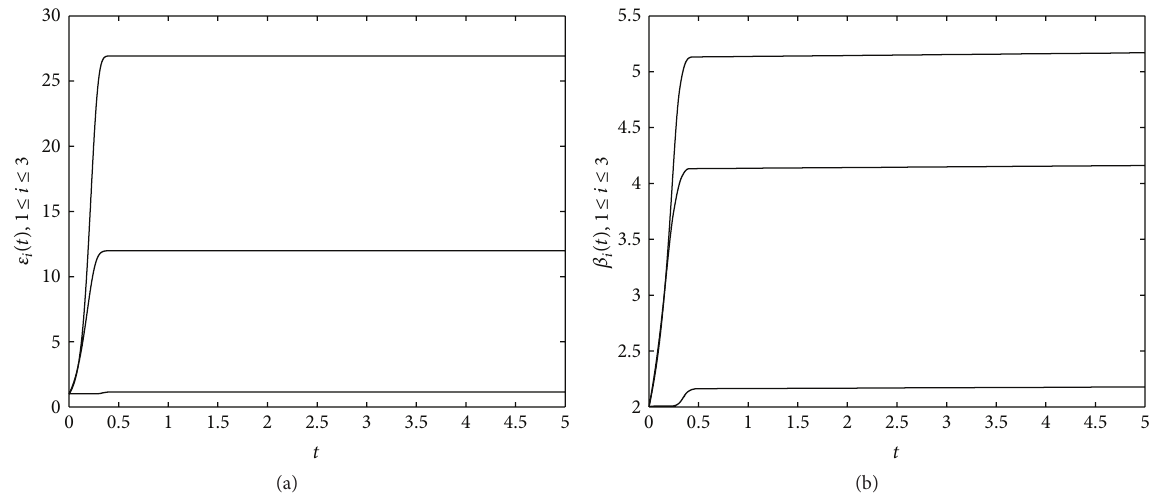
Figure 4: The adaptive control gains of (47): (a) the adaptive gains 𝜀 𝑖 , 1 ≤ 𝑖 ≤ 3 , (b) the adaptive gains 𝛽 𝑖 ,1 ≤ 𝑖 ≤ 3